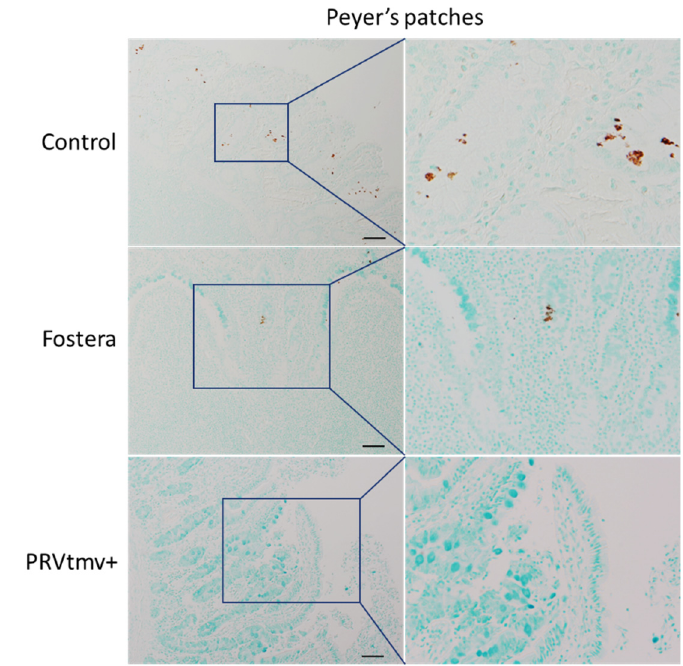
Figure 19. Immunohistochemistry showing the PCV2b antigen in tonsil ( A ) and intestine (Peyer’s patches) ( B ). Tissue sections were prepared, cleared, rehydrated, and subjected to immunostaining using anti-PCV2b mAb and horseradish peroxidase-labeled secondary antibodies. Immunostained sections were counterstained with 0.5% methylene green stain and examined under a microscope after mounting. PCV2 antigens in tissues were confirmed by the presence of bright-golden brown positive signals. ( A ) Note that PCV2b antigens are detected in the tonsil ( A ) and Peyer’s patch ( B ) of the control unvaccinated pig. Regardless of PRVtmv+ or Fostera vaccine group, PCV2b Cap antigen could not be detected in the tonsils of pigs. In one pig (#2310) of the Fostera group, PCV2b Cap-specific antigen in a tiny area of Peyer’s patch could be detected ( B ). Magnification 100×. Bar = 100 µm.